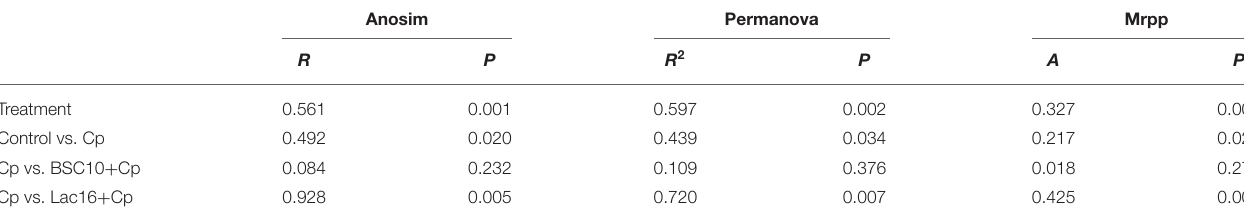
TABLE 3 | ANOSIM, PERMANOVA, and MRPP analysis of microbial diversity among different treatments. Anosim Permanova Mrpp R P R 2 P A P Treatment Control vs. Cp